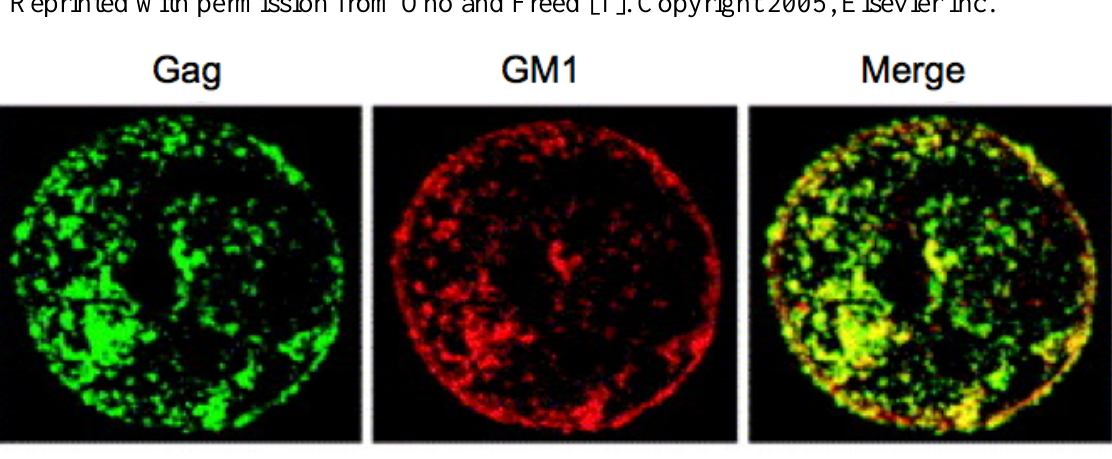
Figure 5. Copatching of HIV-1 Gag proteins with the raft marker GM1. Before fixation, Jurkat cells expressing HIV-1 Gag were treated with cholera toxin B subunit to stain GM1. Cells were then fixed, permeabilized, and Gag proteins were detected with an anti-p17 MA antibody. Gag and GM1 show colocalization, as shown in yellow in the merged image. Reprinted with permission from Ono and Freed [1]. Copyright 2005, Elsevier